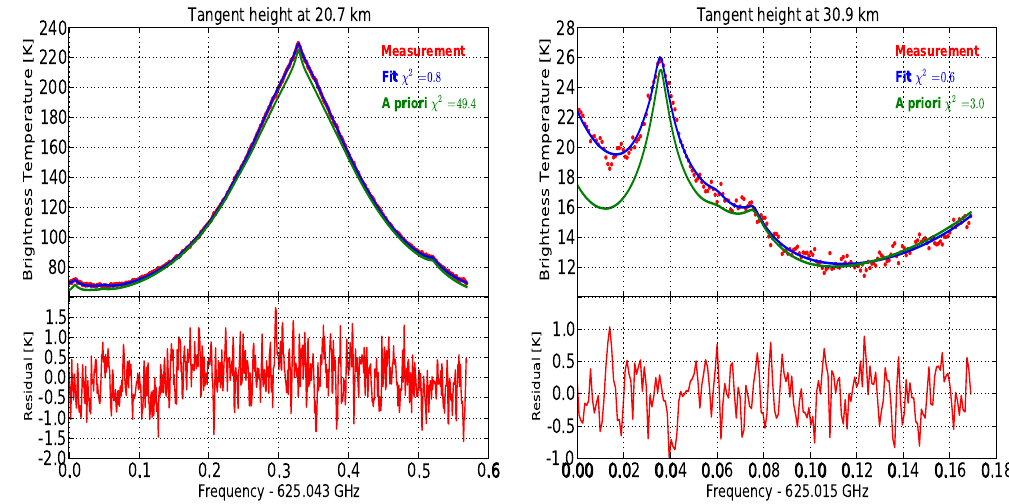
Fig. 4. Left panel: spectral line of O 3 at 625.371GHz for a tangent height of 21km measured in the window A-w1 along with the a priori and fitted spectra. The lower panel shows the residual of the fit. Right panel: Spectral window A-w4 for a tangent height of 31km (upper panel) and fit residual (lower panel). The weak HOCl line at 625.076GHz is located between two stronger lines of O 3 v1,3 and OO 18 O at 625.051GHz and 625.091GHz, respectively. Data are from a scan measured at 24:00LT on 14 April 2010 at a latitude of 8 ◦ N.